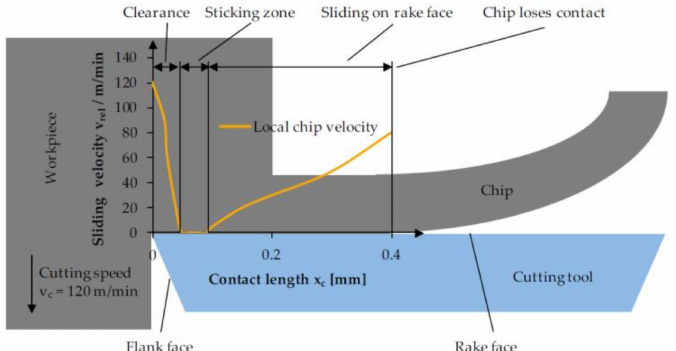
Figure 6. Evolution of the sliding velocity along the tool-material interface [71].